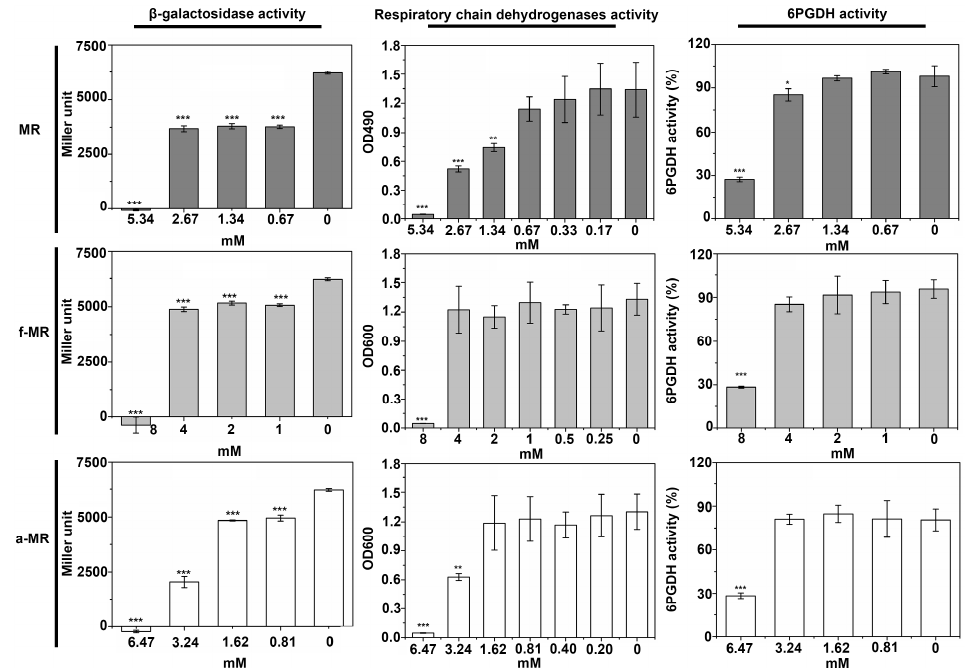
Figure 5. The results of enzyme activity assays are shown. The same amount of bacteria without peptide was used as a negative control, dubbed “0”. The symbol * and **, as well as *** represent that there is a significant difference between the testing groups and the negative group at α < 0.05 and α < 0.01, as well as α < 0.001, respectively. Results are mean values ± SD of three independent experiments. * α < 0.05, ** α < 0.01, *** α < 0.001 vs. control.